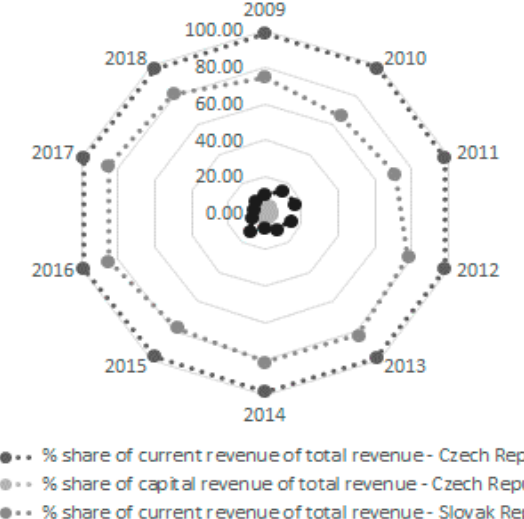
Figure 7. The share of current and capital revenues of the municipalities in Slovak Republic and in Czech Republic in the time period 2009–2018, Source: Ministry of Finance of Slovak Republic, Czech Statistical Office, own processing.